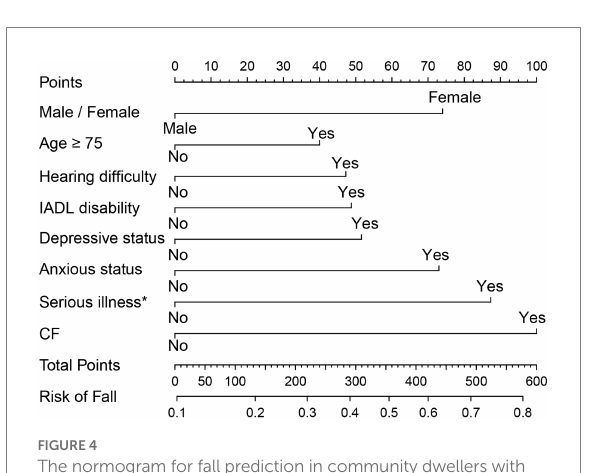
FIGURE 4 The normogram for fall prediction in community dwellers with CF. IADL: instrumental activities of daily living. CF : cognitive fraity. *Serious illness in the past 2 years.